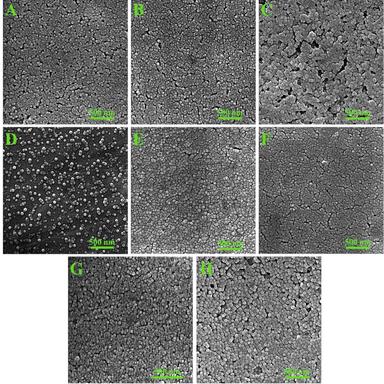
FESEM images for multi-functionalized copolymer nanoparticles of (A) PMMA, (B) PMMA-PBA, (C) PMMA-COOH, (D) PMMA-PDMAEMA, (E) PMMA-PHEMA, (F) PMMA-PGMA, (G) PMMA-PAAm, and (H) PMMA-PMAAm.